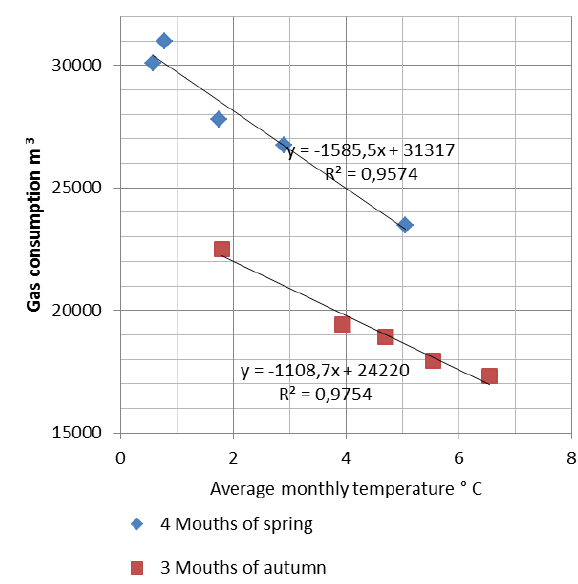
Fig.8. Dependence of consumption on